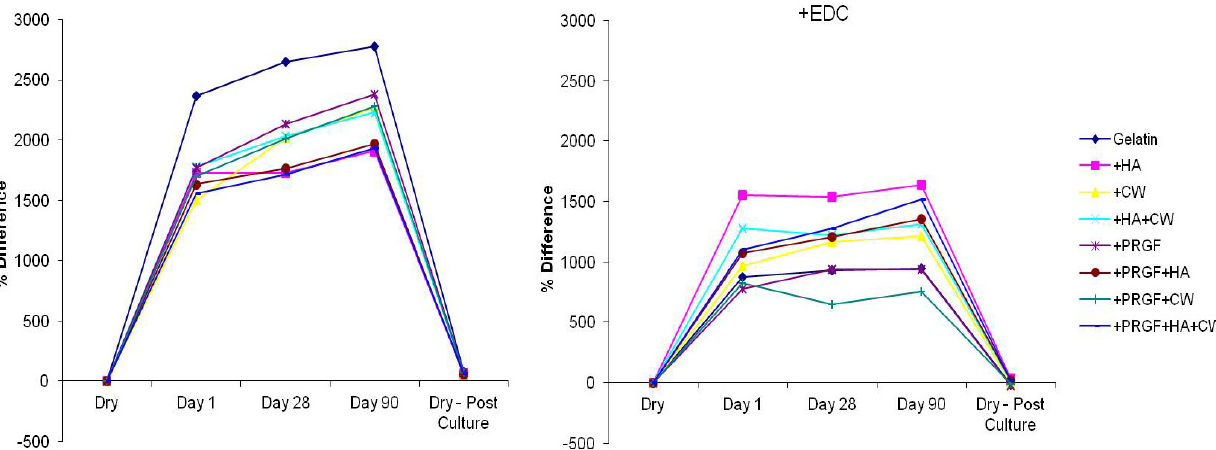
Figure 1. Percent difference in